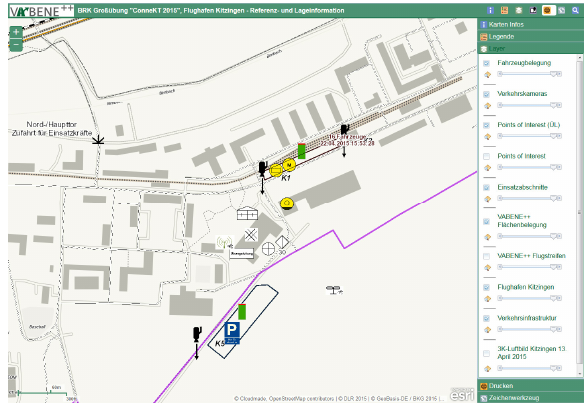
Classification and accuracy results as represented